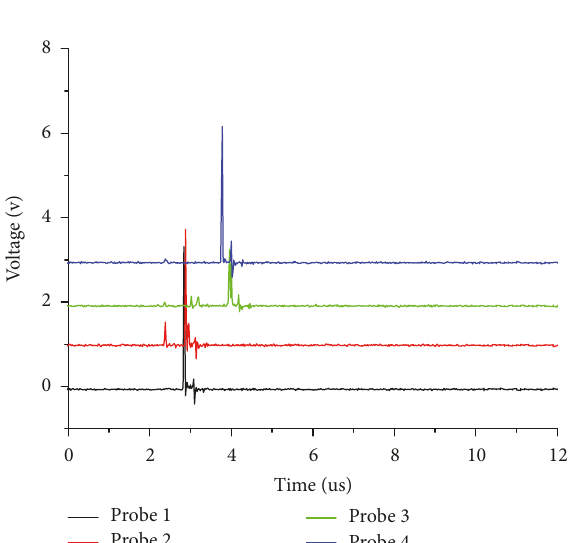
Figure 4: Signal of electric probes.